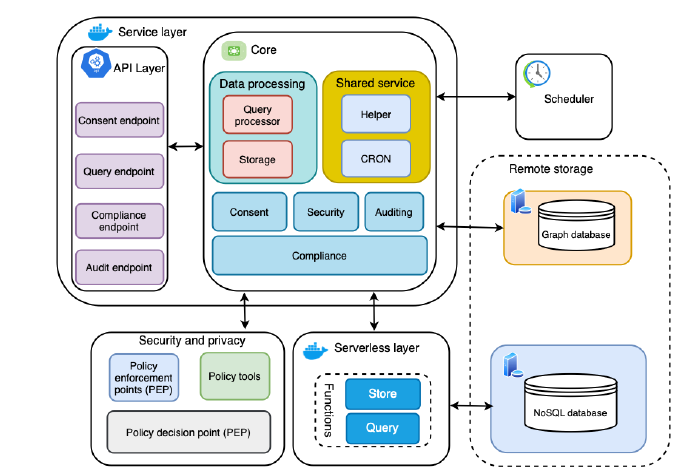
Figure 2. Architecture of the automated GDPR compliance verification